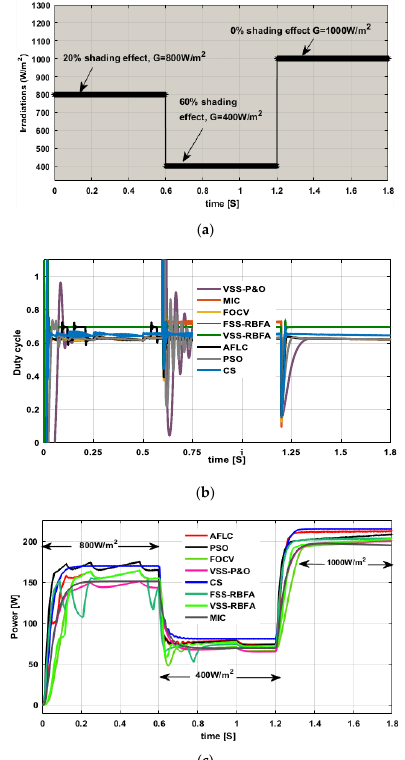
Figure 17. ( a ) Variable irradiation condition (0.8, 0.4, and 1 kW/m 2 ); ( b ) duty cycle of CBC by applying different MPPT techniques at (0.8, 0.4, and 1 kW/m 2 ); and ( c ) output power of CBC by applying different MPPT techniques at (0.8, 0.4, and 1 kW/m 2 ).